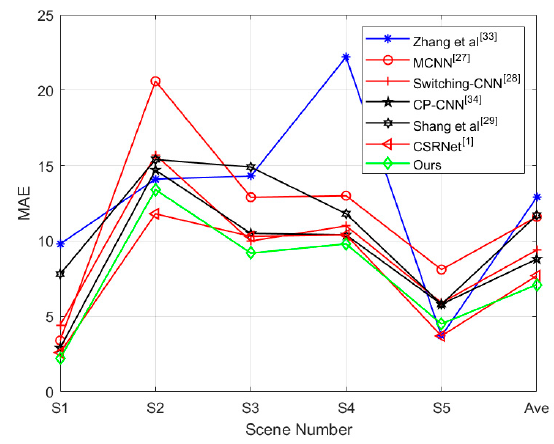
Figure 8. Two sample images in WorldExpo’10 dataset. ( a , b ) are two sample images in WorldExpo’10 dataset. ( c , d ) are their density map generated by DSA-CNN for two images, respectively.